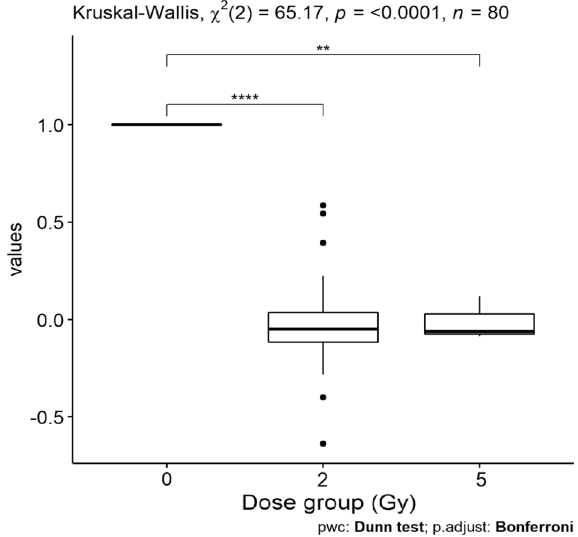
Figure 4. The boxplot of relative change of AML against the dose group in 19 patients for which one or both parotid glands were delineated as organs at risk. The baseline relative values are indicated as 100%.